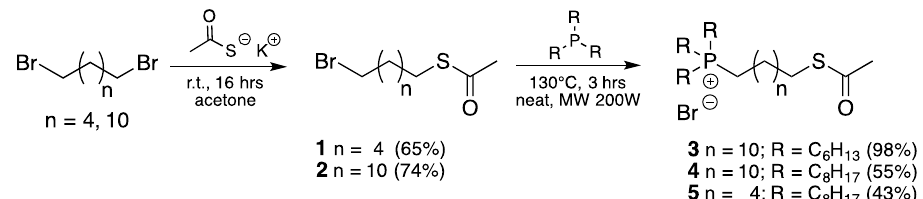
Scheme 1. Synthesis of the trialkylphosphoniums bromide target